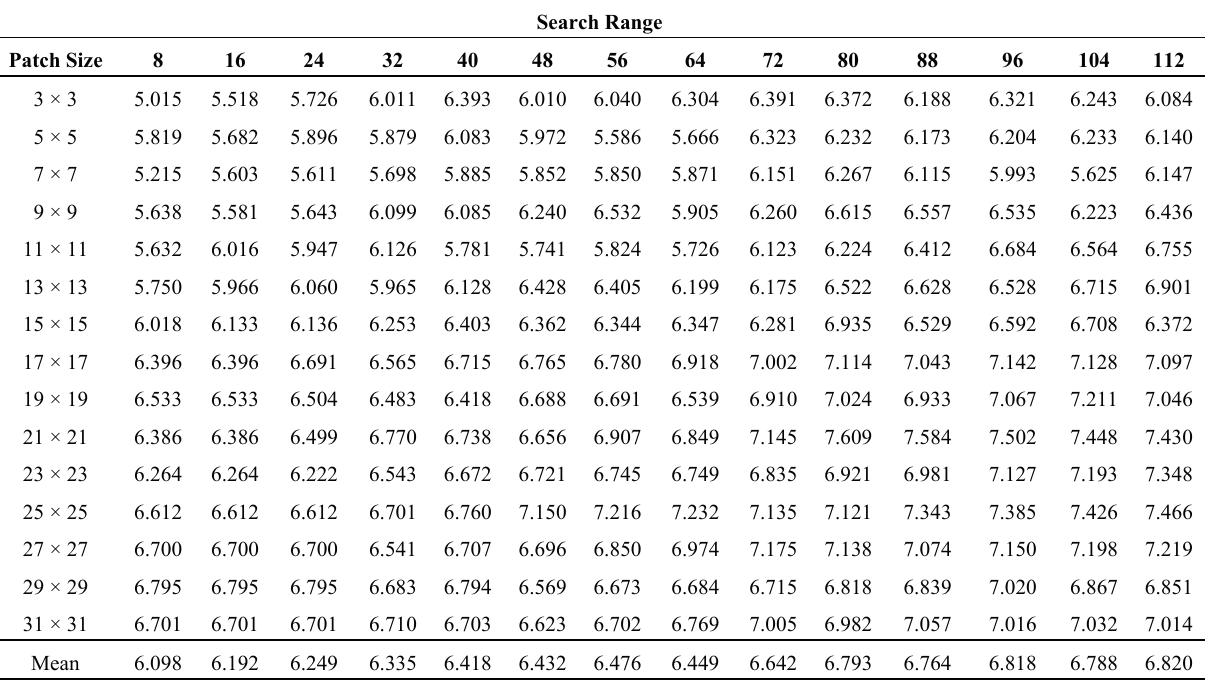
Table 5. Mean PSNR improvement vs. search ranges. Search Range